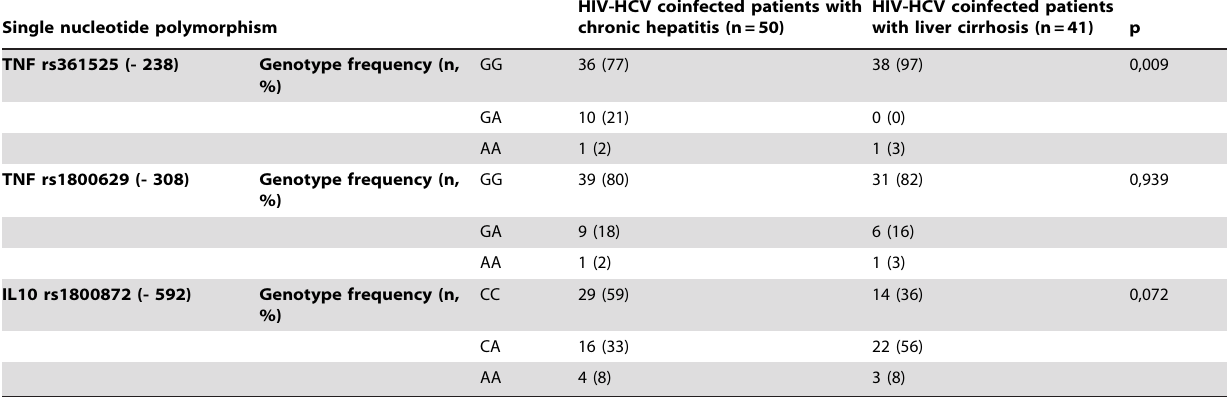
Table 3. Single nucleotide polymorphism of TNF- a and IL-10 genes studied in patients with HIV-HCV coinfection with chronic hepatitis or liver